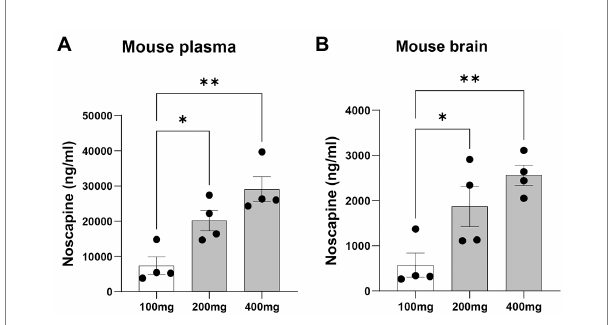
FIGURE 2 Plasma and brain noscapine levels in noscapine treated mouse. Mouse was orally administered with increasing concentrations of noscapine: 100, 200, and 400 mg/kg. Noscapine was measured in mouse plasma (A) and brain homogenate (B) at 60 min post-dose using Liquid Chromatography Tandem Mass Spectrometry (LC-MS/